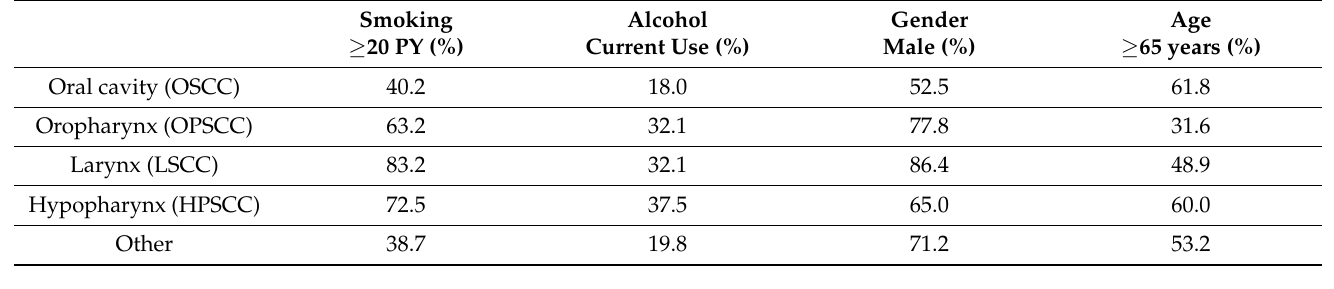
Figure 3. OPSCC incidence in the southwestern Finland population from 2005–2015. In the OPSCC cancer treatment algorithm, radio-RT and chemoradiotherapy (CRT) are the main treatment options. Of 193 OPSCC patients, 7.8% ( n = 15) received definitive radiotherapy, and 23.3% ( n = 45) received definitive chemoradiotherapy as treatment. Most patients (52.8%, n = 102) were treated with a combination of surgery and CRT, while a minority (3.6%, n = 7) of patients received a combination of surgery and RT. In addition, the proportion of patients treated by surgery only was 3.6% ( n = 7). Palliative care or no treatment at all was offered to 8.8% ( n = 17) of patients. The five-year OS, DSS, and DFS of patients with OPSCC were 54.4%, 66.3%, and 61.7%, respectively. Treatment outcomes were compared between CRT ( n = 147) and RT ( n = 22) treated patients. Patients who received RT or CRT as an adjuvant treatment were included along with patients who received definitive RT or CRT. Patients treated with CRT had better OS ( p < 0.001), DSS ( p = 0.002), and DFS ( p = 0.008), as shown in Figure 4. OS was 63.9% in the CRT group and 31.8% in the RT group, DSS was 75.5% in the CRT group and 50.0% in the RT group, and DFS was 71.4% in the CRT group and 50.0% in the RT group. The group of patients treated by surgery only was not analyzed.